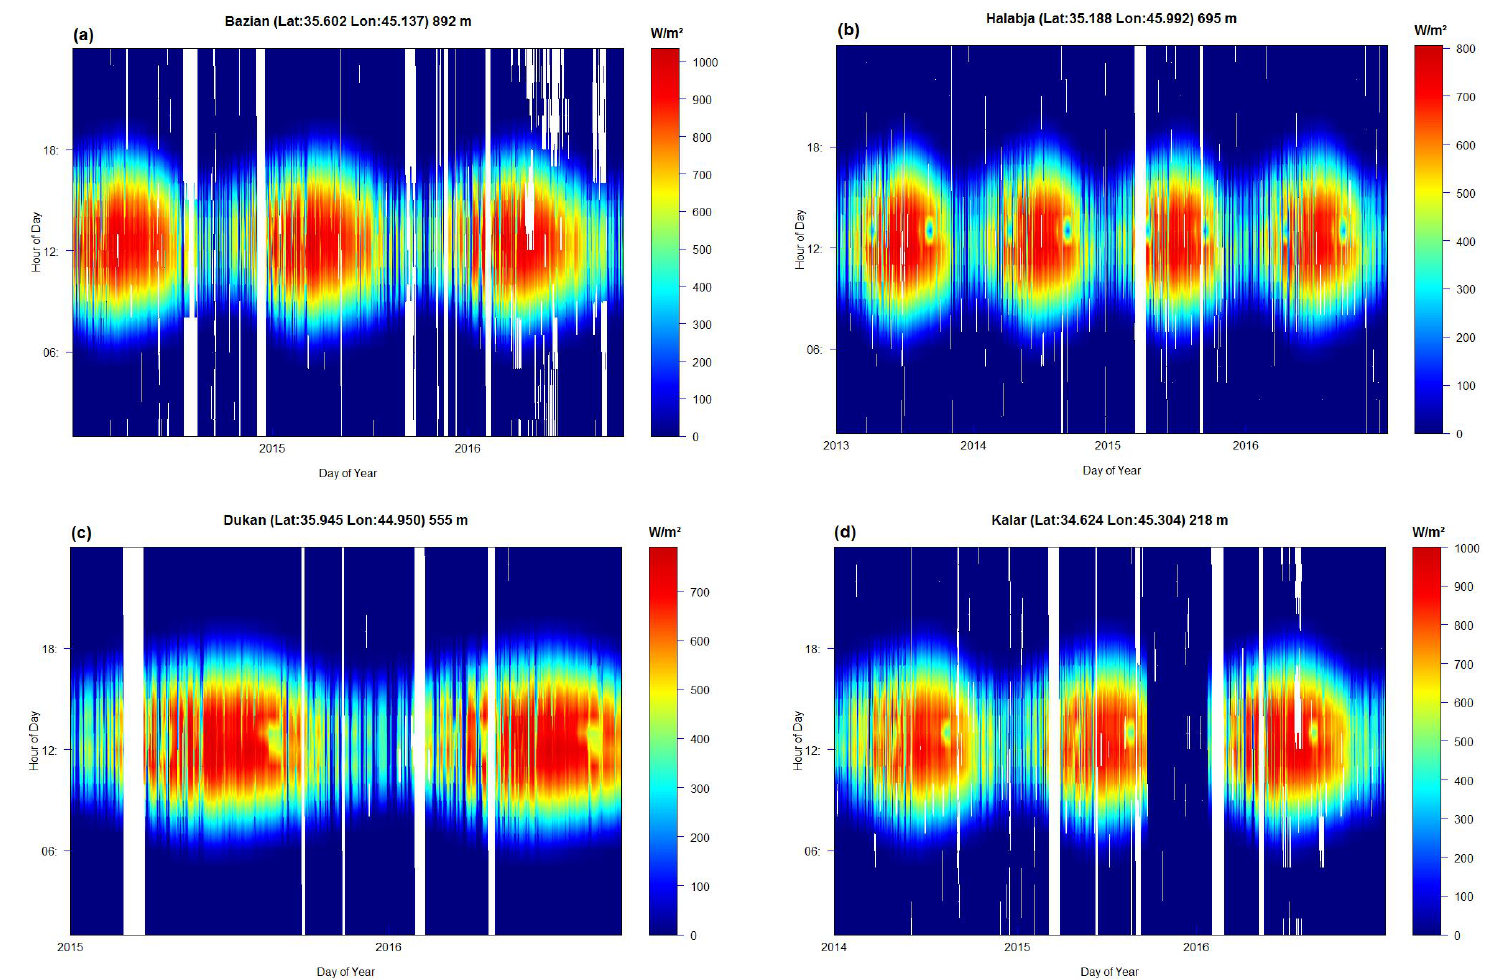
Figure 4. Fingerprint plot GHI time series of hourly data for stations namely ( a ) Bazian, ( b ) Halabja, ( c ) Dukan and ( d ) Kalar, white colour is NA values.